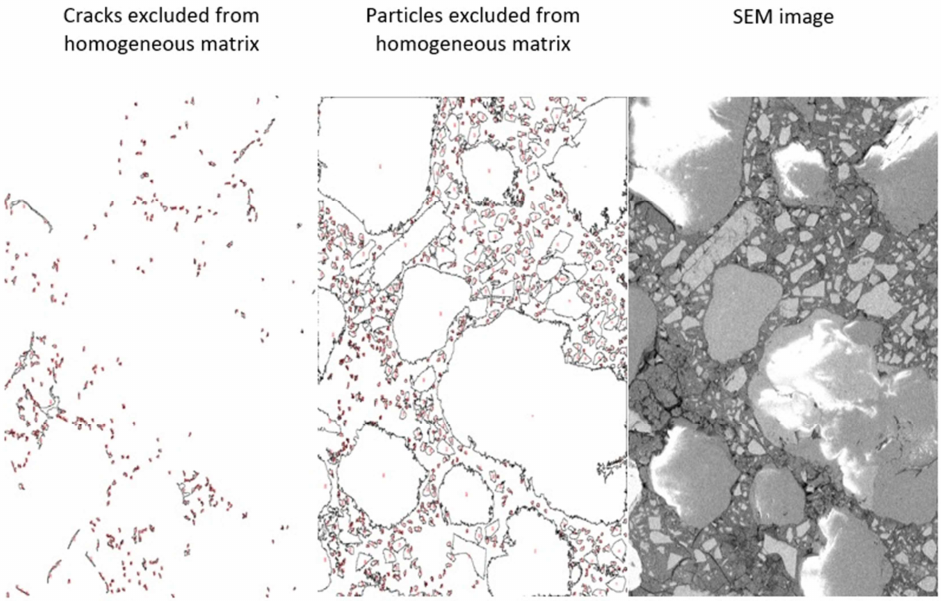
Figure 9. Steps of conducted digital image analysis (20S40). Table 5. Computed areas from SEM